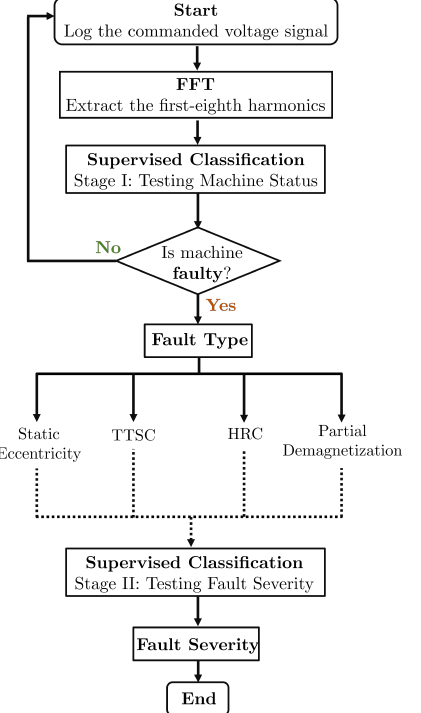
Figure 19. Flowchart of fault detection, separation, and severity estimation